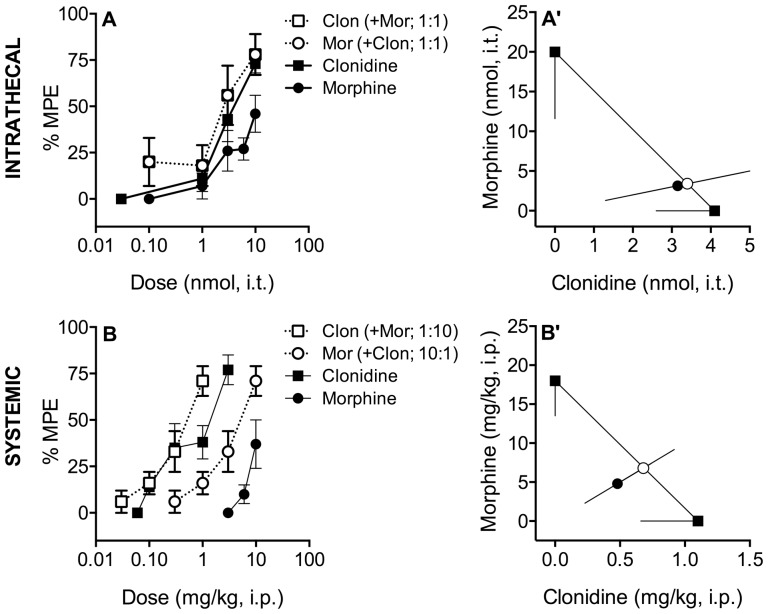
Effects of Morphine and Clonidine in the Rotarod Sedation Assay.
A. Rotarod retention was challenged by intrathecal morphine, clonidine or both. Morphine (•) and clonidine (▪) inhibited rotarod performance in a dose-dependent manner with similar potency. When the agonists were co-administered at a constant ratio of 1∶1 (○ morphine; □ clonidine), no increases in potency or efficacy were observed. A′. Isobolographic analysis applied to the data from Figure 2A. The y-intercept represents the ED50 for morphine and the x-intercept represents the ED50 for clonidine. The lines directed from each ED50 value toward zero represent the lower 95% confidence limits of each ED50. The line connecting these two points is the theoretical additive line. The unfilled circle on the theoretical additive line represents the calculated theoretical ED50 value of the combination if the interaction is additive. The observed combination ED50 (•) is not significantly (p<0.05; t-test) different from the theoretical additive ED50 (○), indicating that the interaction is additive. B. Systemically administered morphine (•) and clonidine (▪) dose-dependently inhibited rotarod performance when administered alone or in combination at a constant morphine∶clonidine dose ratio of 10∶1 (○ morphine; □ clonidine). B′. Isobolographic analysis applied to the data from Figure 2B. The observed combination ED50 (•) is not significantly (p<0.05; t-test) different than the theoretical additive ED50 (○), indicating that the interaction is additive. Data pictured were obtained 15 minutes following intrathecal (Figures 2A, A′) and 20 minutes following systemic administration (Figures 2B, B′). Error bars represent ±SEM for each dose point (n = 6–10 animals/dose). See Table 1 for ED50 values.